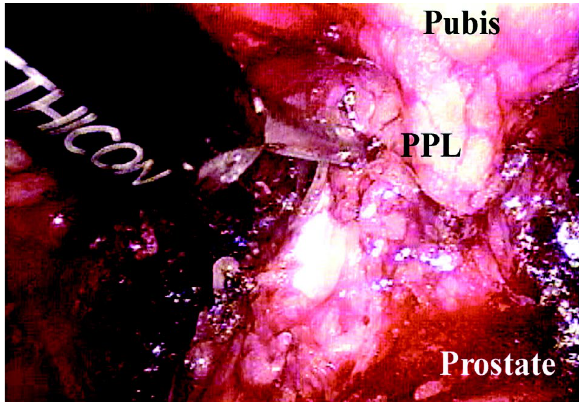
Figure 3 – Sectioning of the puboprostatic ligament (PPL) with harmonic scalpel.